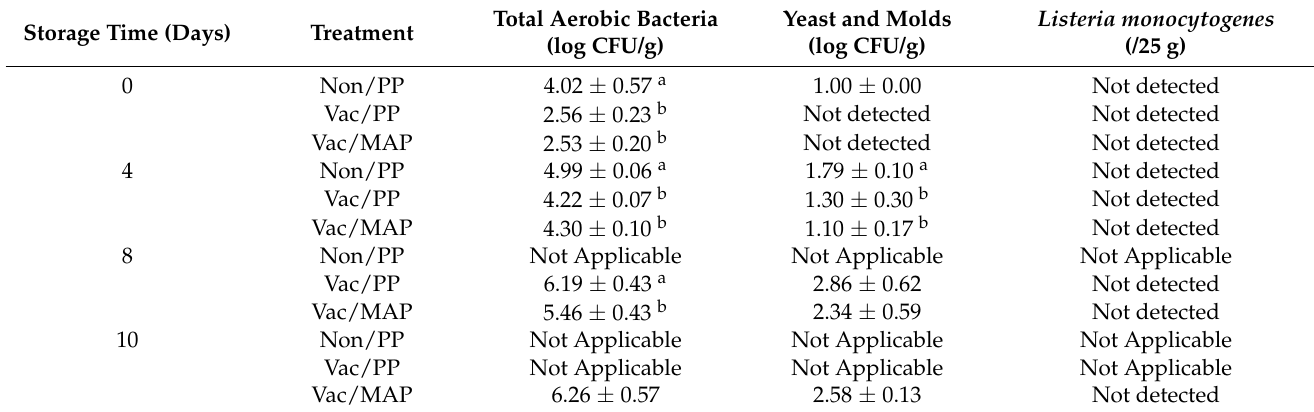
Table 2. Microbiological analysis of the whole packaged fresh-cut vegetables during storage at 4 ◦ C.